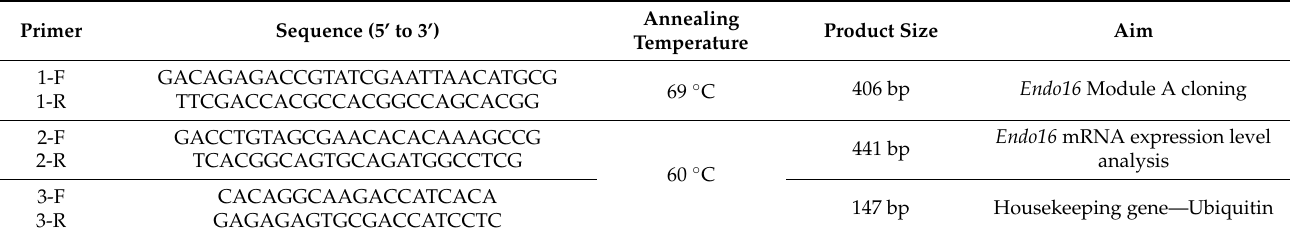
Table 1. Primers used for